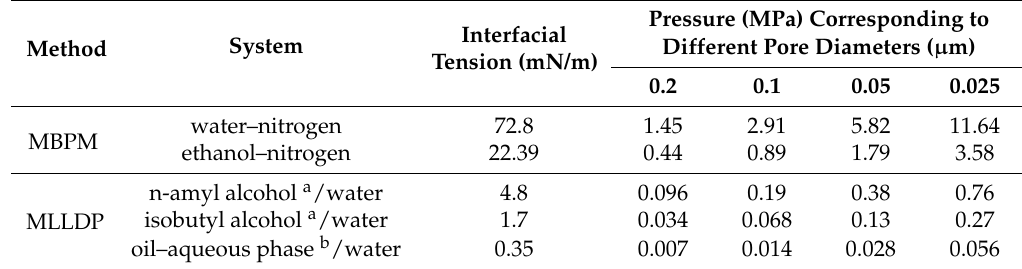
Table 2. A comparison of operation pressures required for MBPM and MLLDP (20 ◦ C, cos θ = 1).